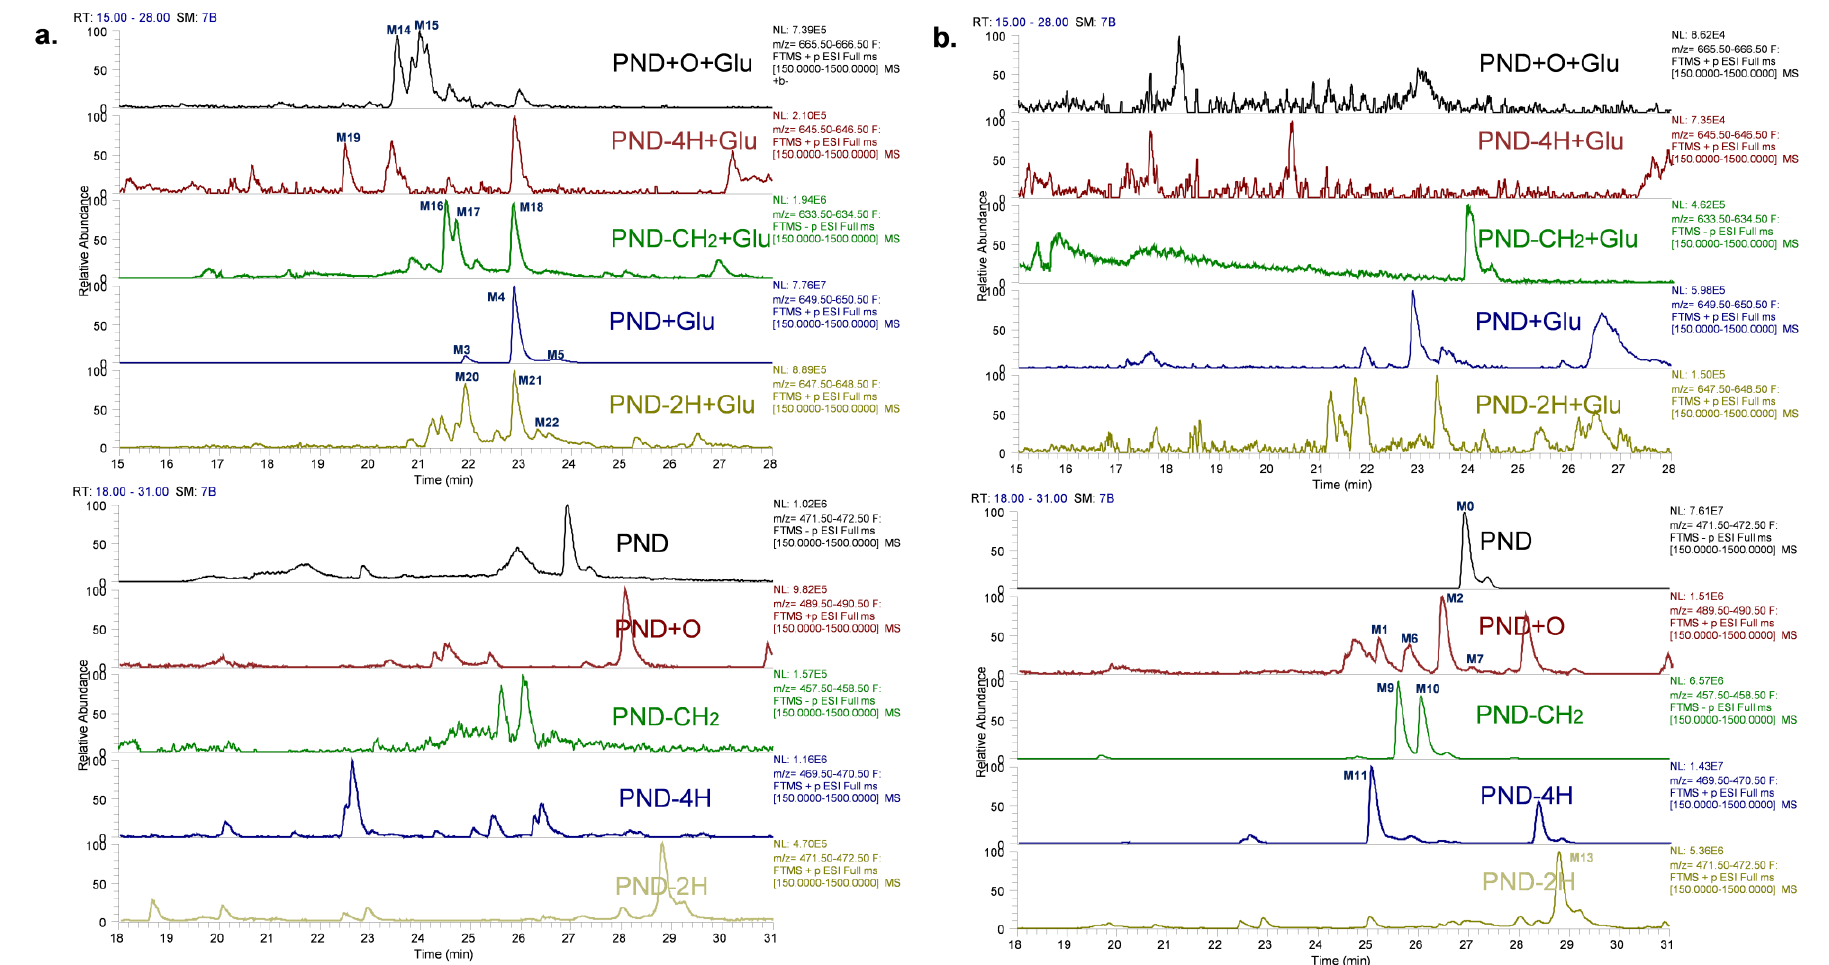
Figure 2. EIC of PND metabolites in rat bile samples. ( a ) . before incubation with β -glucuronidase, ( b ) . after incubation with β -glucuronidase.